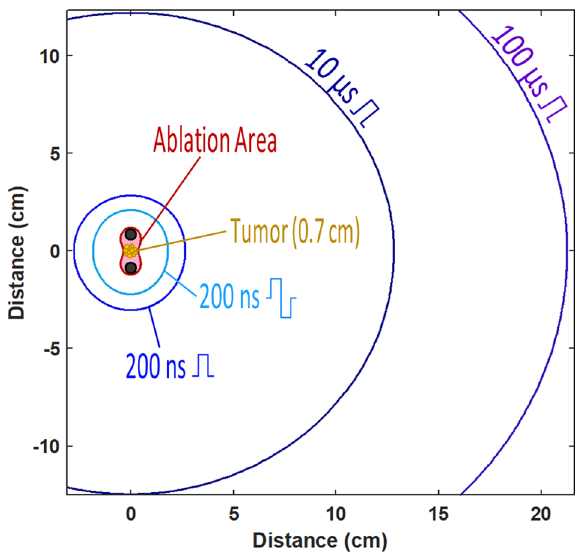
Figure 10. The projected areas of nerve stimulation when a hypothetical tumor is ablated by pulses of different shape and duration. This example uses data from Figs. 2F and 9B and assumes uniform dielectric properties of the tissue. The tumor is placed between two needle electrodes which pierce the tissue orthogonal to the plane shown in the figure. Pulse amplitude is set to produce the electric field sufficient to ablate the tumor (“Ablation Area”). The larger radii mark the projected distances at which the nerve stimulation is expected when the tumor is ablated by pulses of a specific shape and duration (legends). See Figs. 2, 9, and text for more details.